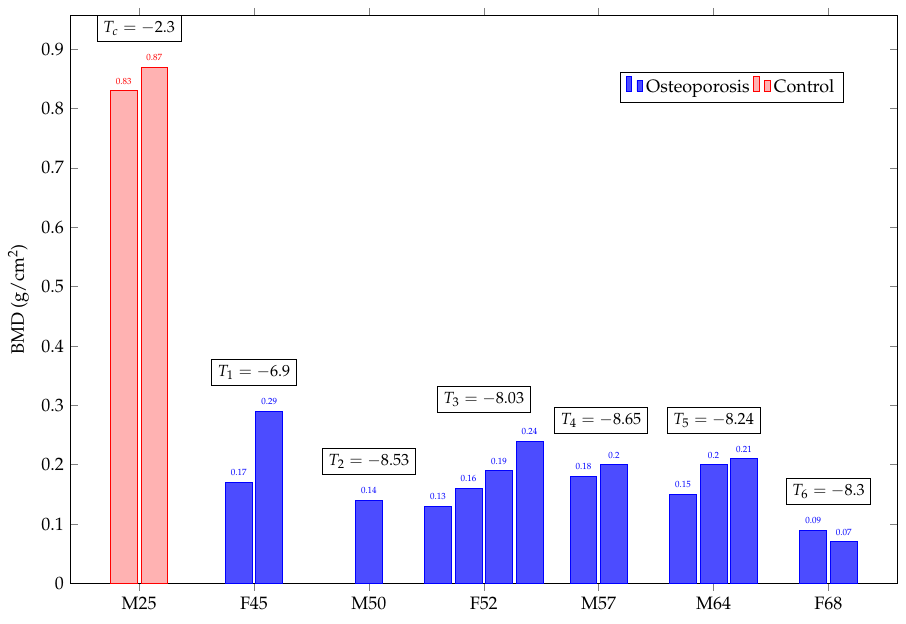
Figure 6. BMD and T-score values for each neck femur sample